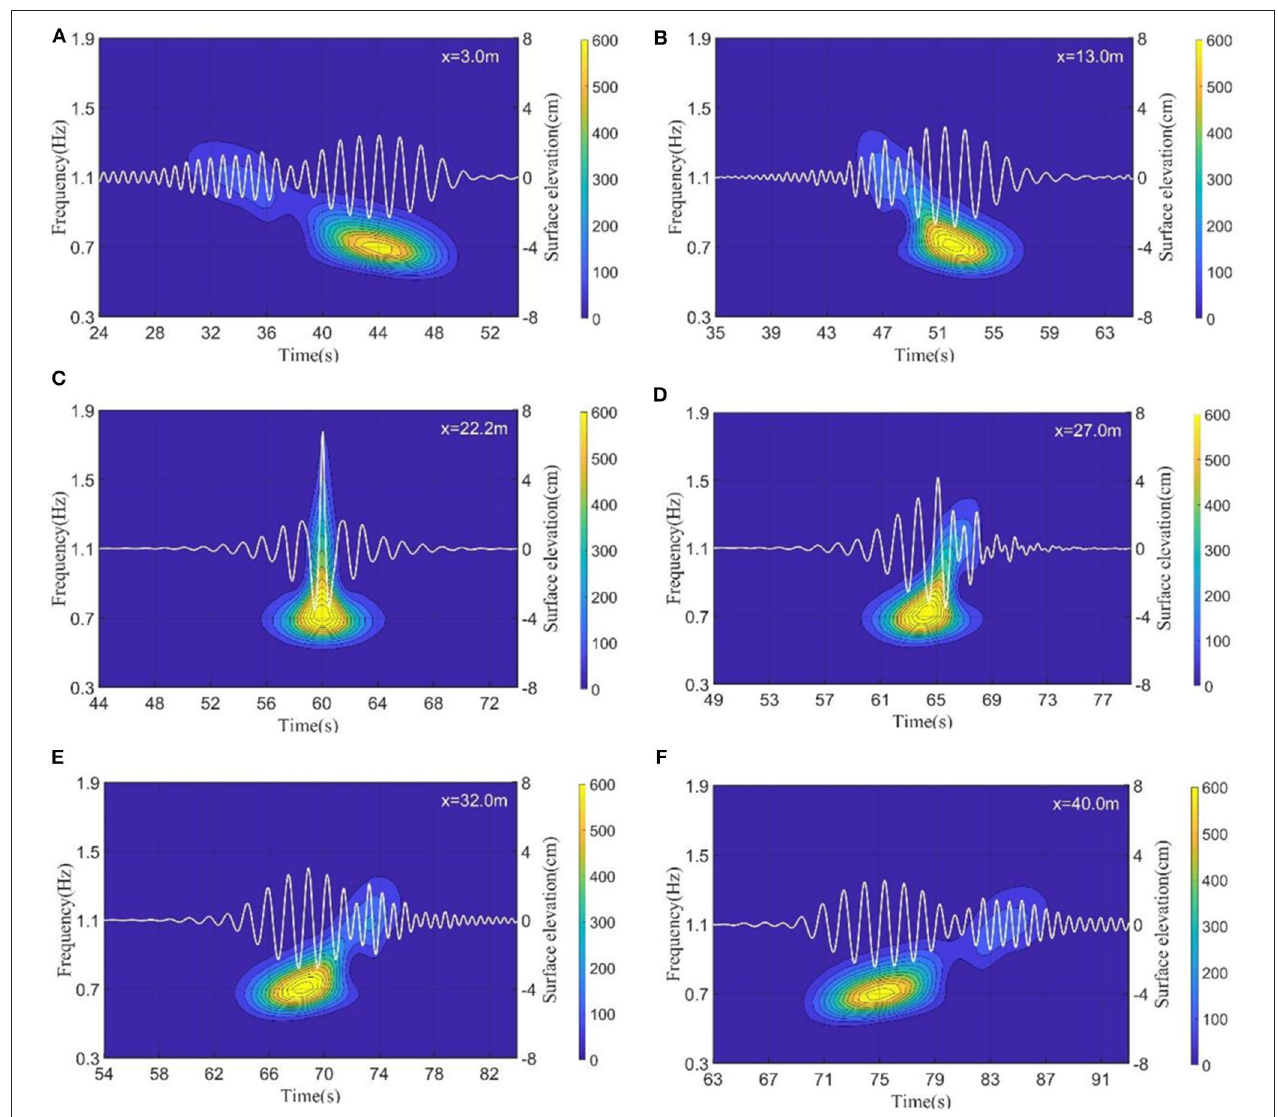
FIGURE 4 | Wavelet spectra at different locations for Case 1_AB. (A) x = 3.0 m, (B) x = 13. 0 m, (C) x = 22.2 m, (D) x = 27.0 m (E) x = 32.0 m and (F) x = 40.0